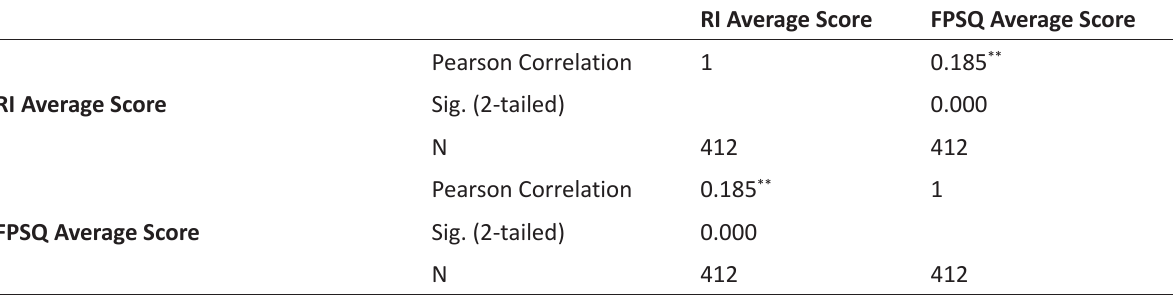
RI Average Score